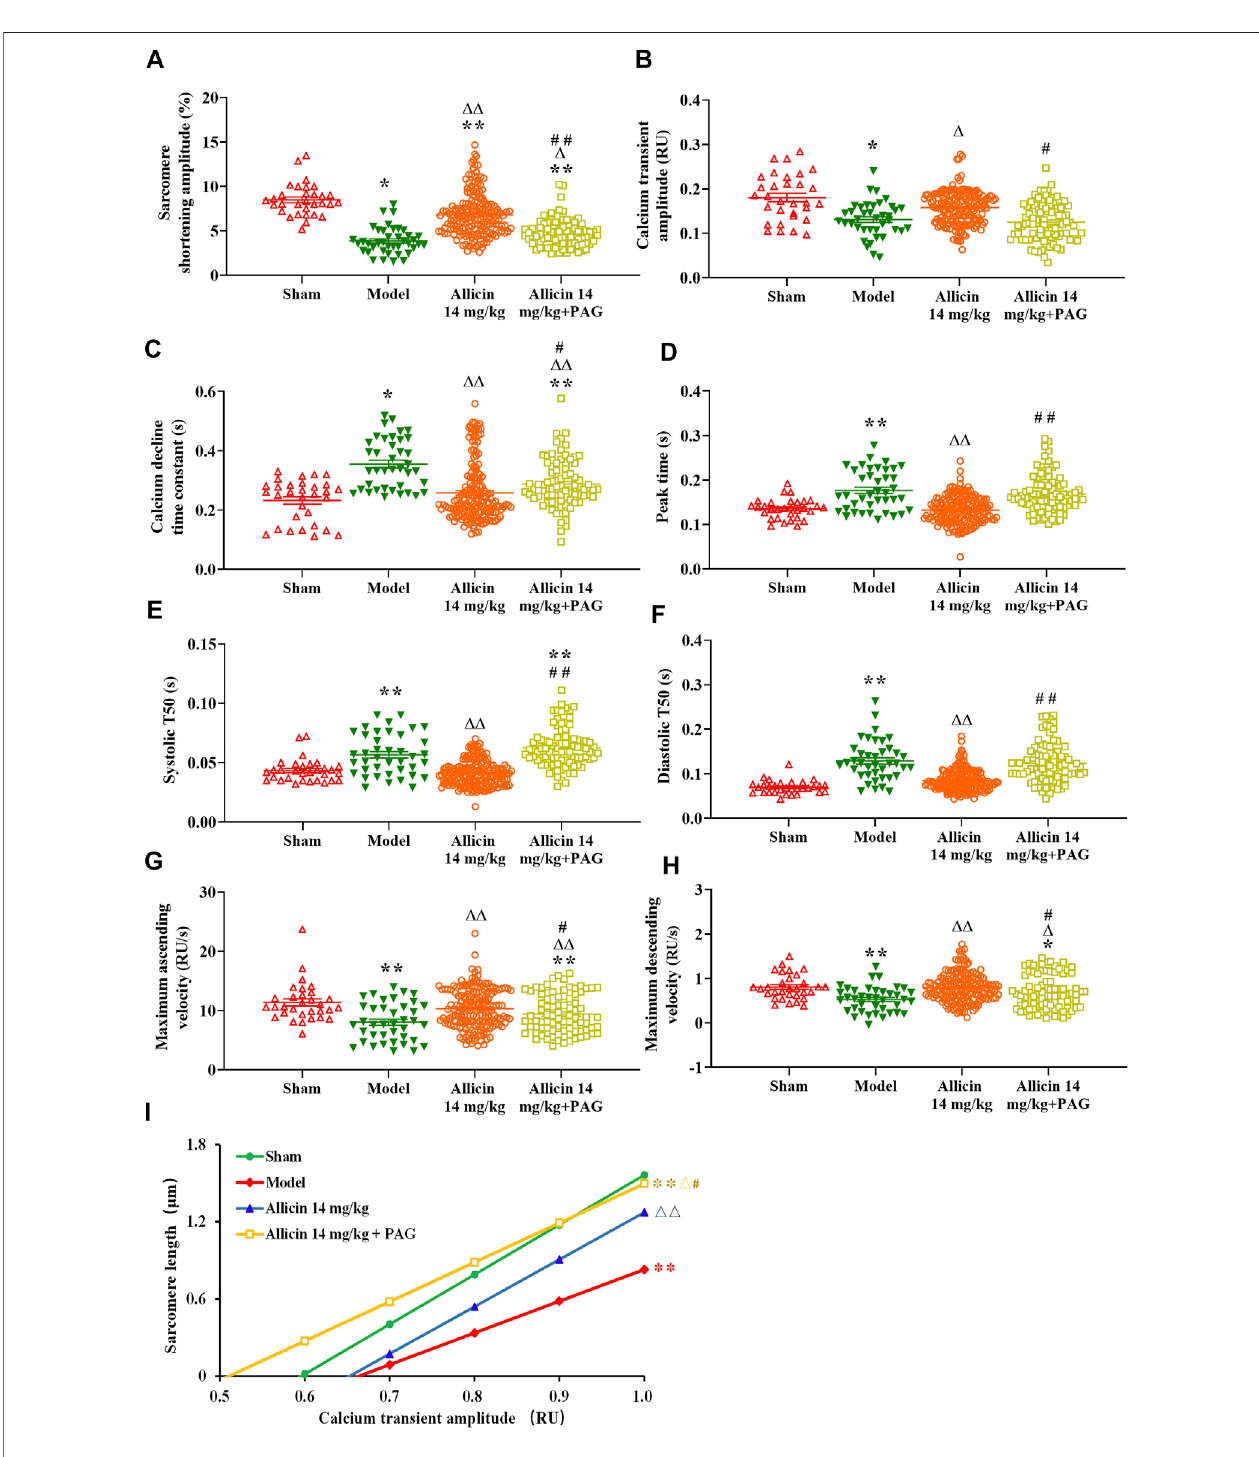
FIGURE 7 | Allicin enhanced cardiomyocyte sarcomere shortening and Ca 2+ transients. (A) Contraction amplitude; (B) Calcium transient amplitude; (C) Ca 2+ decline time constant; (D) Peak time; (E) Systolic T 50 ; (F) Diastolic T 50 ; (G) Maximum ascending and descending velocities; (H) Maximum decline time constant; (I) Myo fi lamentsensitivity.Dataarepresented asmean ± S.E.M ( n (cid:1) 31 – 175cardiomyocytesfrom 3 ‒ 5rats). * p < 0.05,** p < 0.01vs.control; △ p < 0.05, △△ p < 0.01vs.the Model group; # p < 0.05, ## p < 0.01 vs. the Allicin 14 mg/kg group. Abbreviations: PAG, DL-propargylglycine; T 50 , half-time of decay.